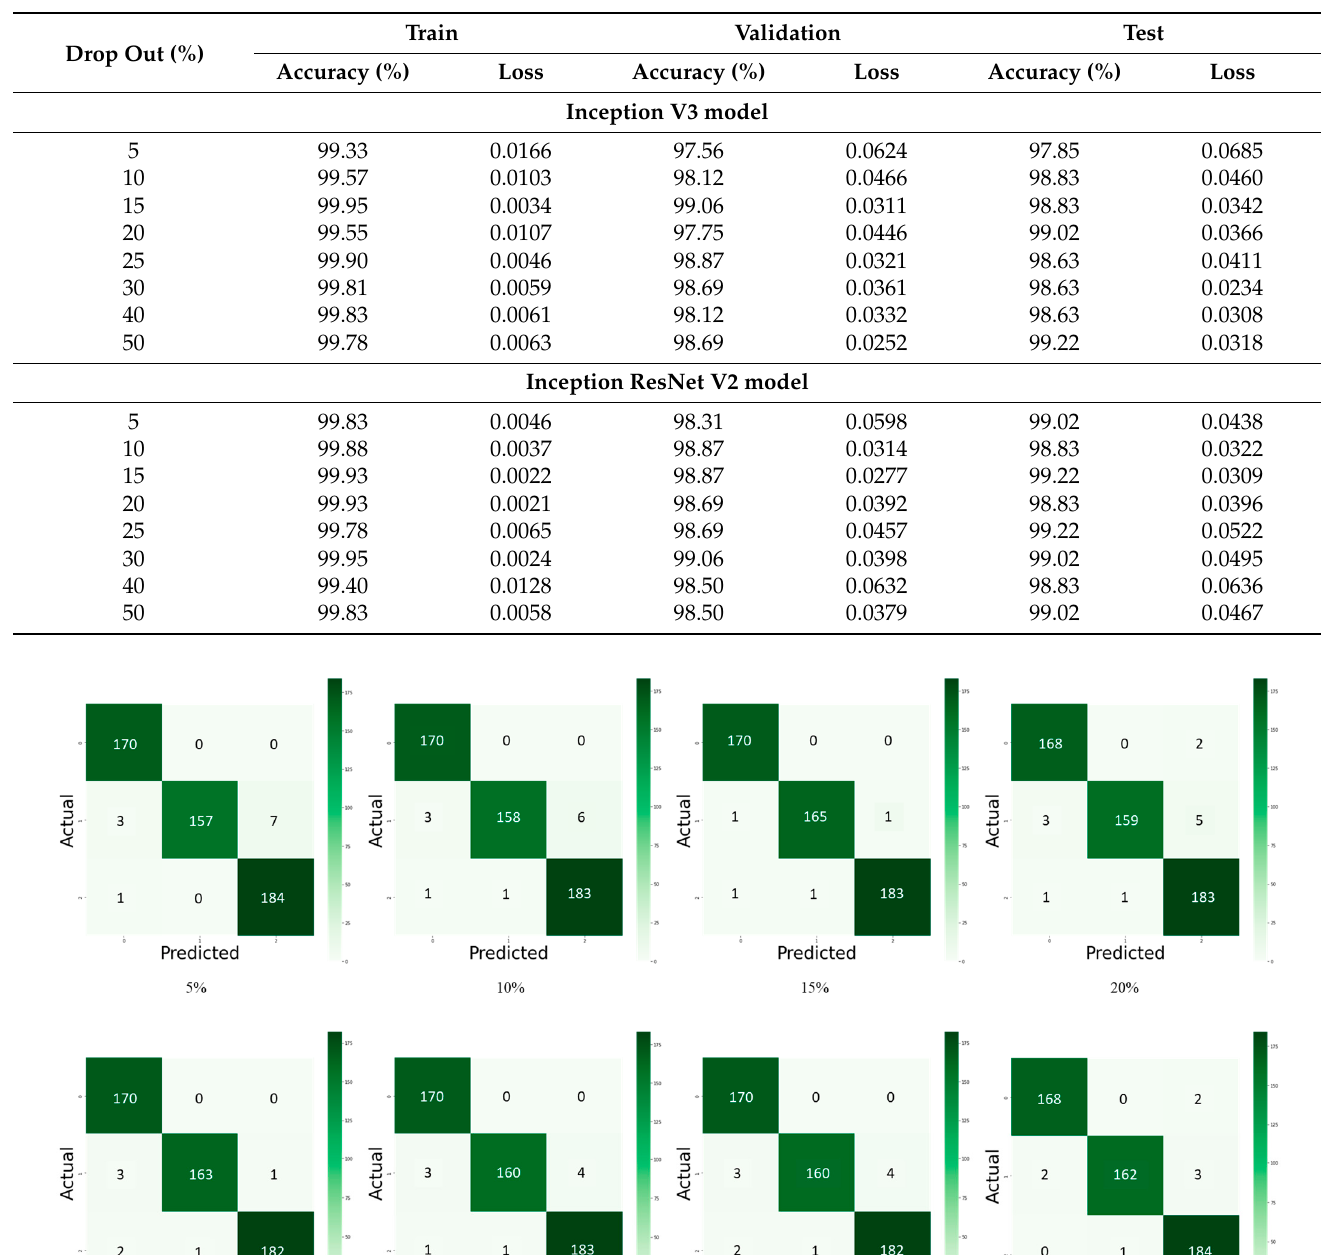
Figure 6. Confusion matrix of tomato leaf disease detection for Inception ResNet V2 model with 5%, 10%, 15%, 20%, 25%, 30%, 40%, and 50% dropout values, numbers represent the classes used for testing where: 0 = Early Blight, 1 = Yellow Leaf Curl Virus, and 2 = Healthy.